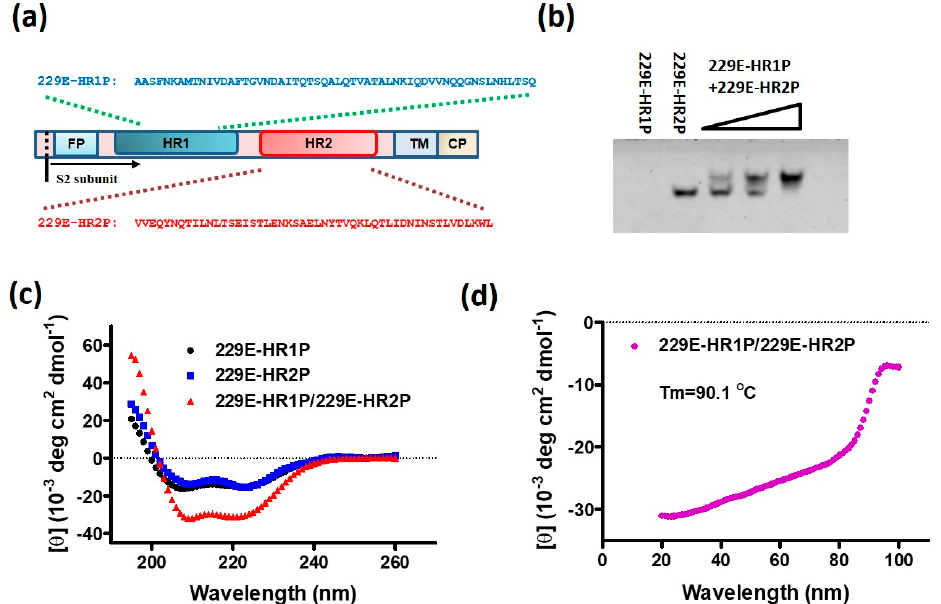
Figure 2. Design and biophysical characterization of 229E-HR1P and 229E-HR2P. ( a ) Schematic representation of HCoV-229E S protein S2 subunit, fusion peptide (FP), heptad repeat 1 (HR1), heptad repeat 2 (HR2), transmembrane domain (TM) and cytoplasmic domain (CP). 229E-HR1P and 229E-HR2P, derived from HR1 and HR2 domains, respectively, and their sequences are shown in the diagram; ( b ) Determination of the interaction of 229E-HR1P at 40 µM with 229E-HR2P at the concentrations of 20, 40, and 80 µM, respectively, by N-PAGE. 6-HB: six-helix bundle; ( c ) circular-dichroism (CD) spectra for 229E-HR1P, 229E-HR2P and their complex in phosphate buffer (pH 7.2); ( d ) Melting curves of the complex formed by 229E-HR1P and 229E-HR2P.